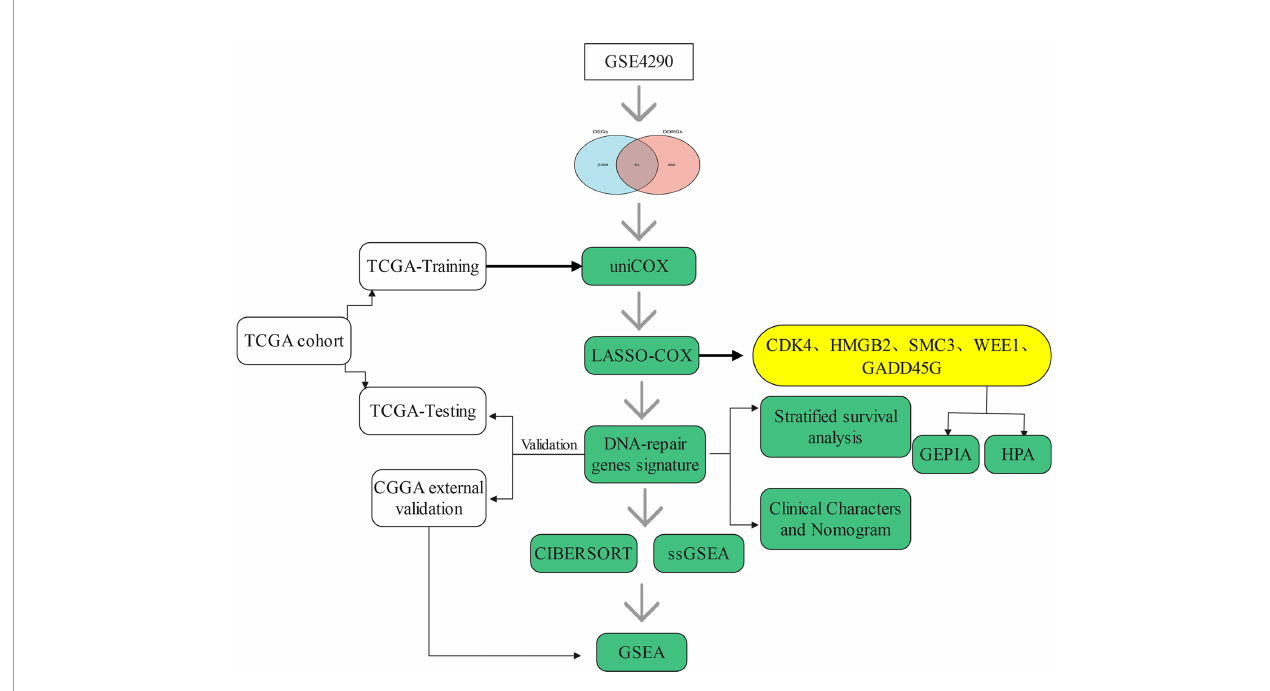
FIGURE 1 | Flow chart of this